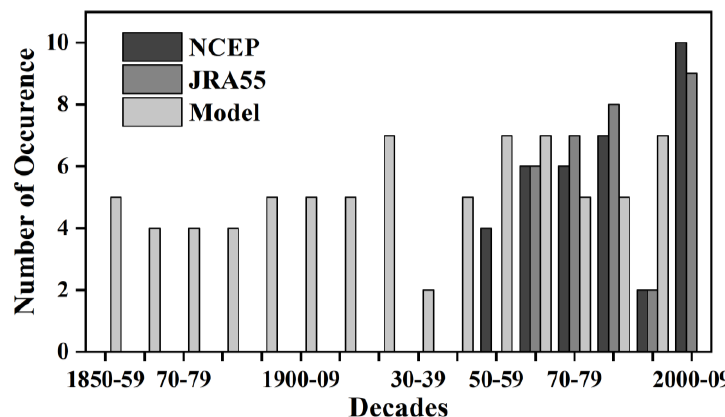
Figure 2. The occurrence number of sudden stratospheric warming (SSW) events in each decade in the NCEP/NCAR ( black ) and JRA55 reanalyses from 1950s/1960s to 2000s ( dark grey ) and in CESM1-WACCM from 1850s to 2000s ( light grey).